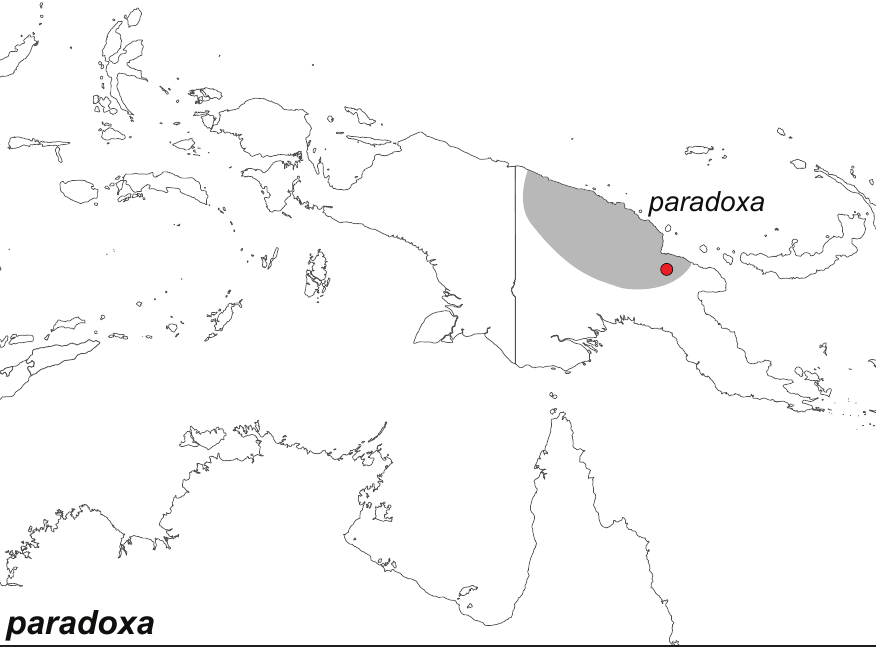
Figure 28. Distribution map of Elymnias